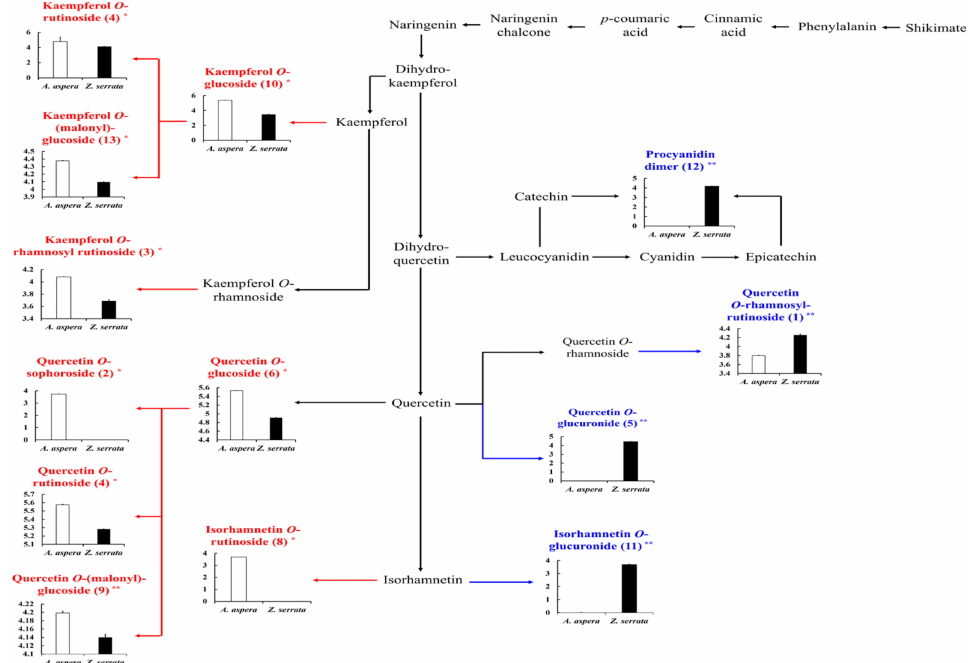
Figure 3. Discriminant metabolic pathway. The unfilled and filled columns represent the relative abundance of discriminant metabolites between A. aspera and Z. serrata . The scheme of the pathway is derived from the KEGG database (KEGG, http://www.genome.jp/kegg). The Y-axis of the graph indicates peak areas at logarithmic scale. The data are presented as the mean ± standard deviation. Differences were considered significant at p -value < 0.05. The metabolite numbers in parentheses are those presented in Table 1. * The discriminant metabolites in A. aspera are indicated with red font ** and those in Z. serrata are indicated with blue